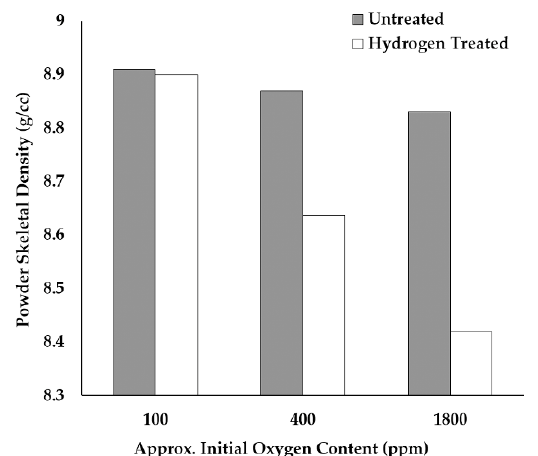
Figure 6. Plot showing the skeletal density of the untreated and hydrogen heat-treated copper powders of varying initial oxygen content, as measured by helium pycnometry.